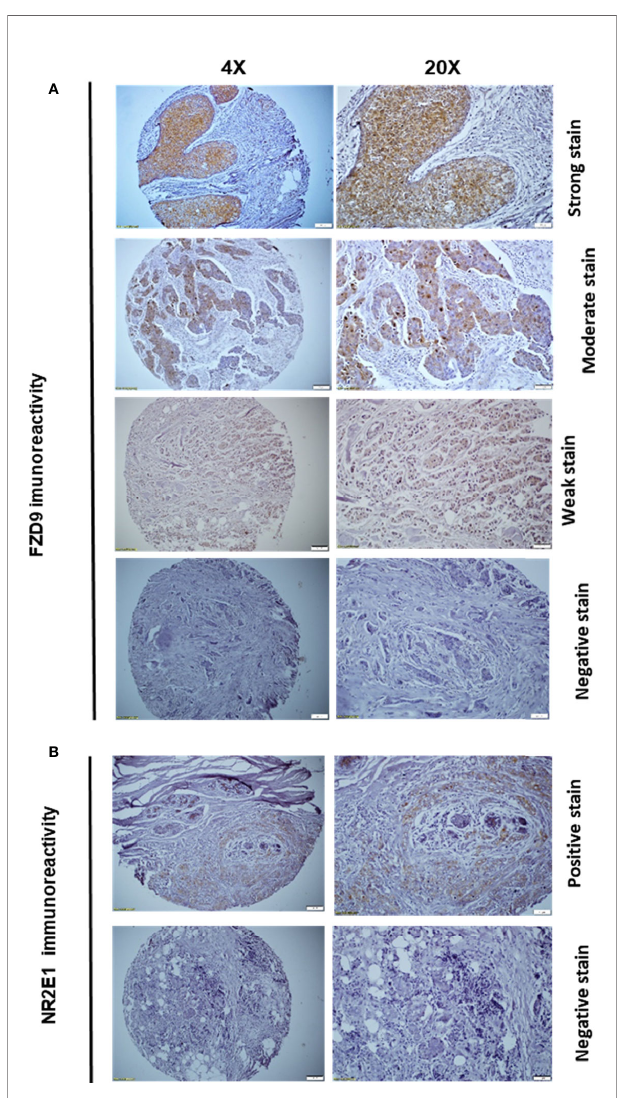
FIGURE 5 | FZD9 and NR2E1 immunoreactivity in our patient cohort that consists of 80 breast cancer patients (A) Representative images of strong, moderate, weak as well as negative FZD9 immunoreactivity. (B) Representative images of positive and negative NR2E1 immunoreactivity.